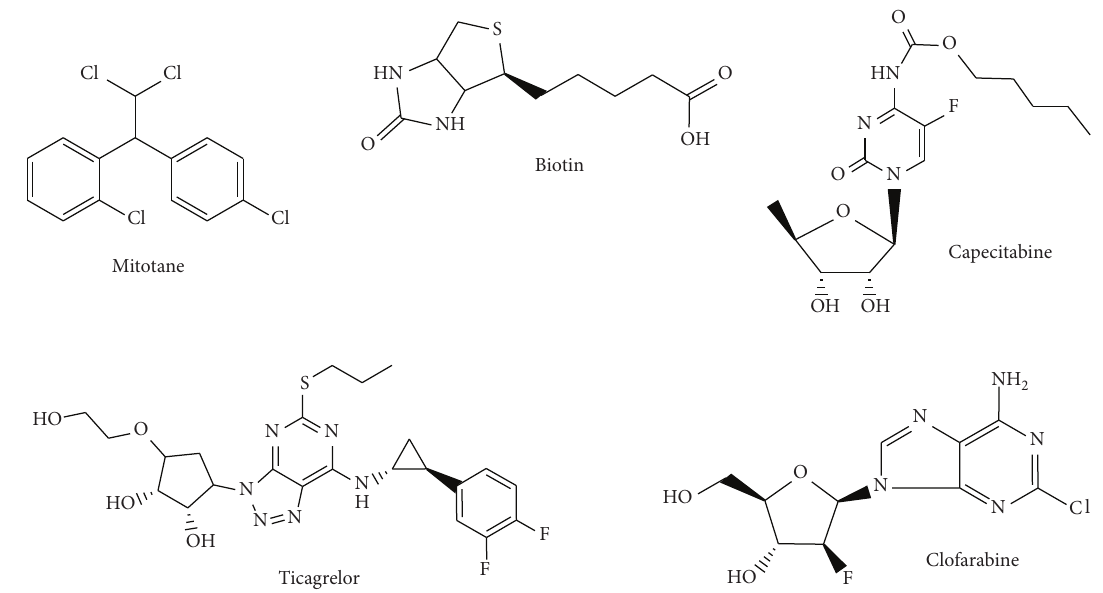
F 3: Example of molecules conforming training and test set having differences in polarizable heteroatoms and electronegativity and, hence, showing or not dyspnea as side effect.